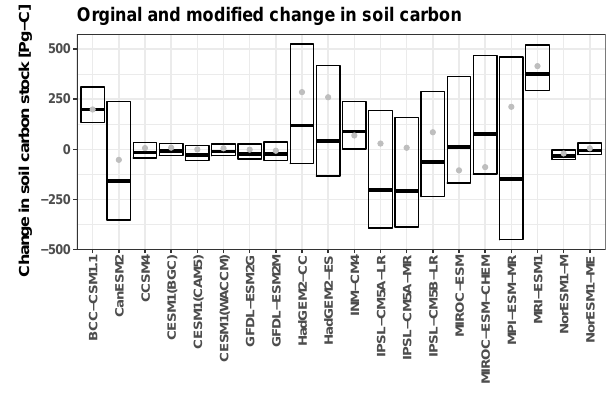
Figure 4. Changes in soil carbon stock (10-year means) over the 21st century from Earth system models (RCP 8.5). Grey dots are the original estimates; the open box is the soil carbon loss after the Q 10 is rescaled using the 2.5, 50, and 97.5% quartiles from the field